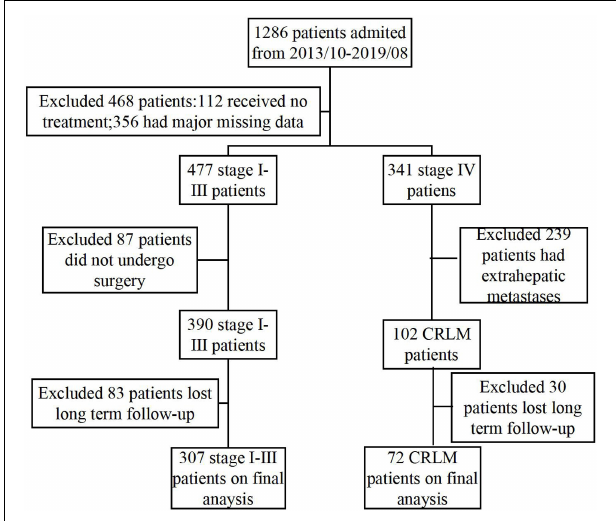
FIGURE 1 | Study design and flowchart.